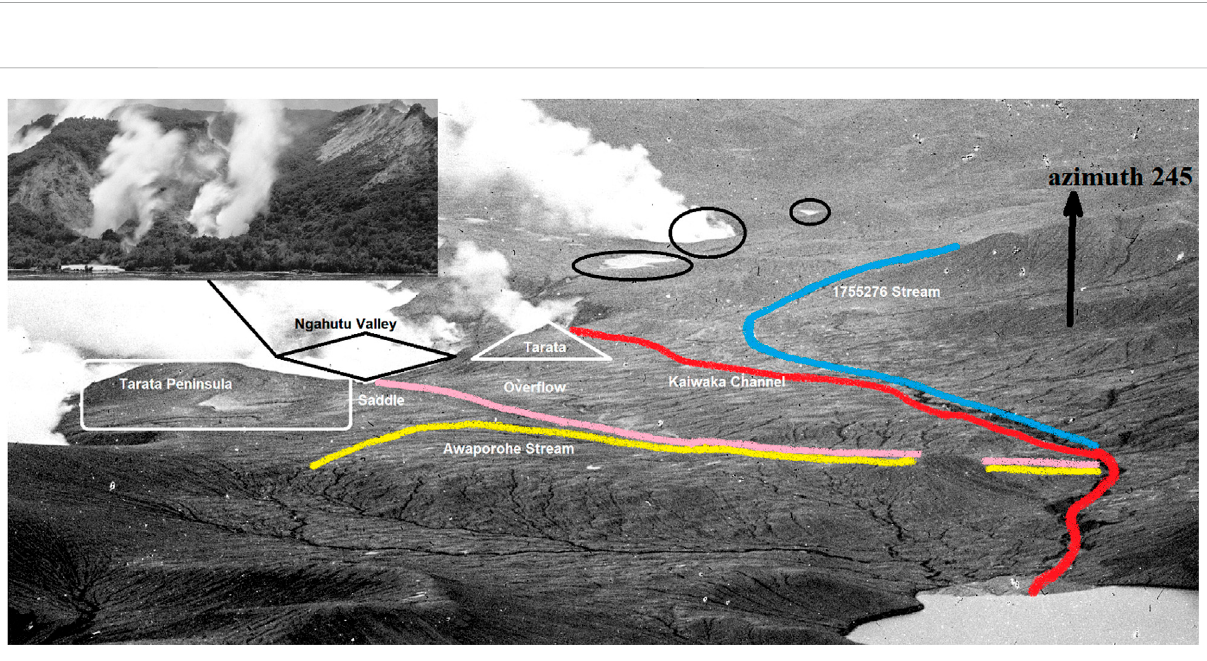
FIGURE 17 Post-eruption isthmus landmarks and streams looking west southwest along (approximately) azimuth 245 ° (Te Papa MA_1269460). Note: This 1886 Muir print is cropped and enhanced to improve watercourse visibility. Blue: main Kumete watercourse, red: Kaiwaka; yellow: Awaporohe; mauve: saddle over fl owis mauve. The Black Terrace Stream, Black Terrace Crater, andBlackTerraceare circled inblack (left to right). The Ngahutu Valley isinset with the Ngahutu and Ngahapu springs. The Tarata (White Terrace) location is the same as Warbrick ’